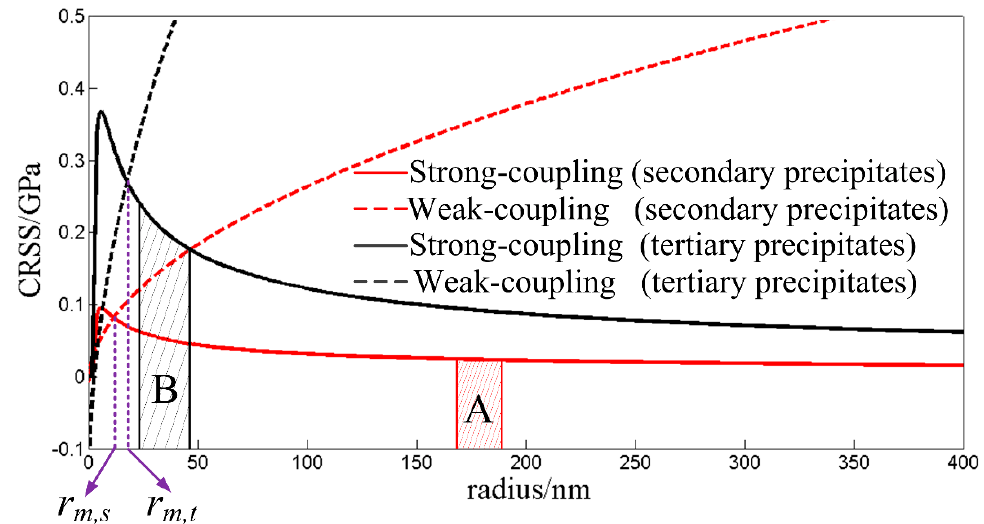
Figure 8. Relationship between the critical resolved shear stress (CRSS) of secondary and tertiary γ’ precipitates and the mean γ’ radius.